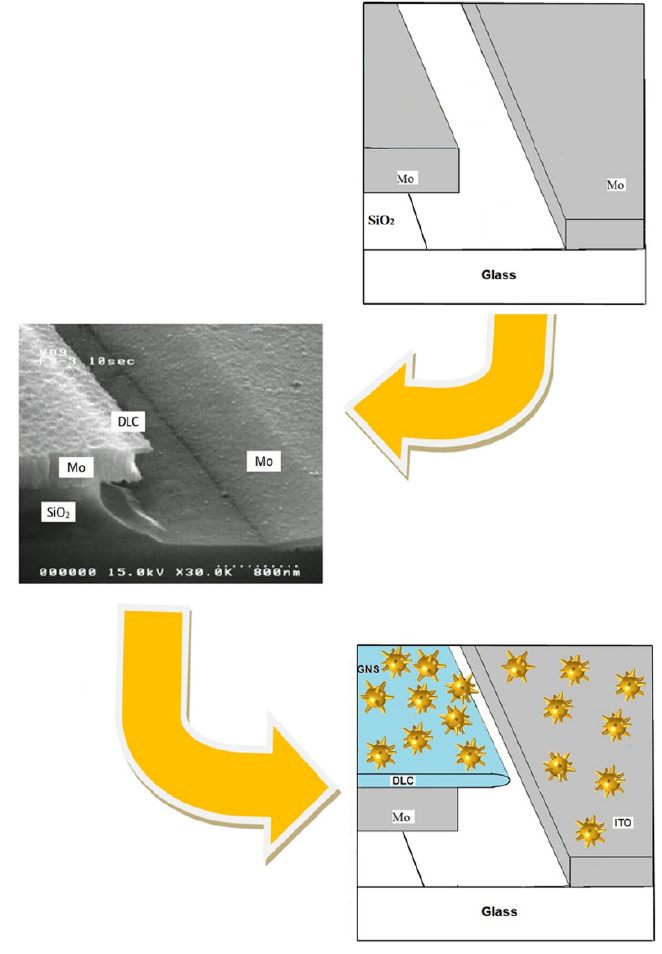
Figure 1. Stages of blade-type emission structure modification: with molybdenum ( upper fragment), composite “Mo-DLC” ( middle fragment) and hybrid “Mo-DLC-GNS” ( lower fragment) blades.